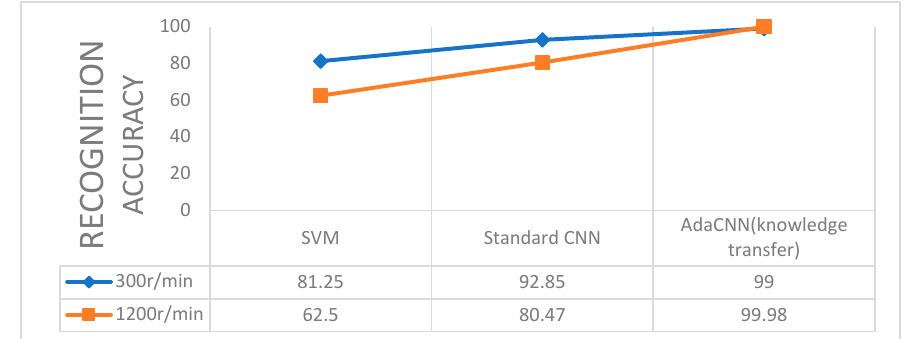
Figure 9. Comparison of transfer learning and direct classification accuracy.